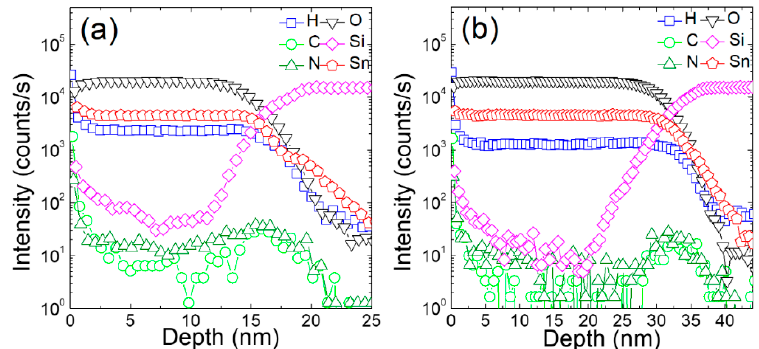
Figure 4. Dynamic secondary ion mass spectrometry (D-SIMS) depth profiles of ( a ) SH-SnO 2 and ( b ) SO-SnO 2 films deposited at 200 °C.